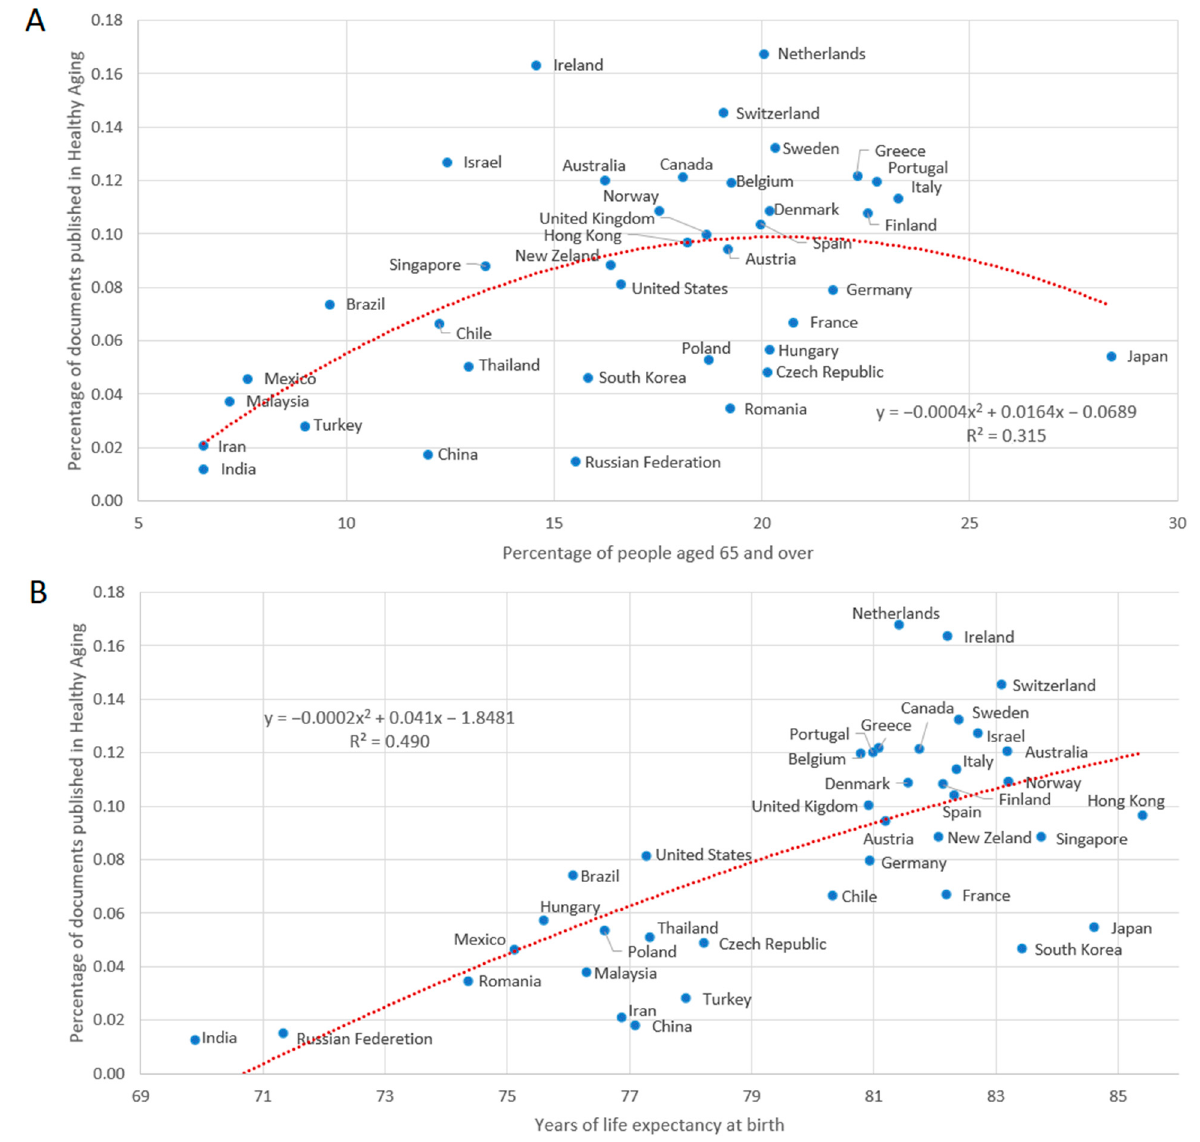
Figure 5. Dispersion and quadratic regression of the percentage of documents published on healthy aging with respect to the total number of published documents (citable items) by country (2011–2020) and the percentage of people aged 65 and over ( A ), as well as the life expectancy at birth (in years) ( B ). Indicators related to aging were set according to data from the World Bank Group for the year 2020. Only countries with at least 50 documents on the subject in the period were considered.